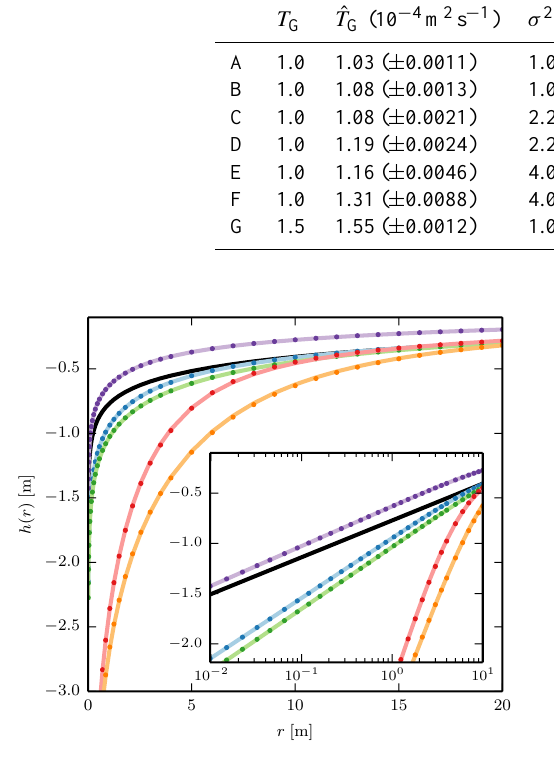
Figure 2. Simulated ensemble means (cid:104) h(r) (cid:105) (dots) and h efw (r) with best-fitting estimates (lines) for multiple ensembles: A (blue), B (green), E (red), F (orange), G (purple). Parameter values are listed in Table 1. Black line shows h Thiem (r) with T G = 10 − 4 m 2 s − 1